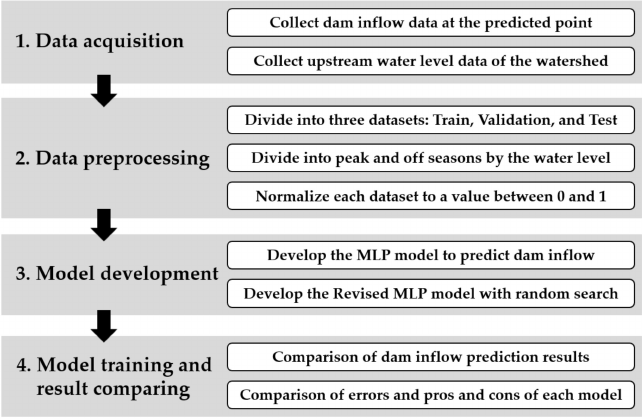
Figure 1. Methodology of the